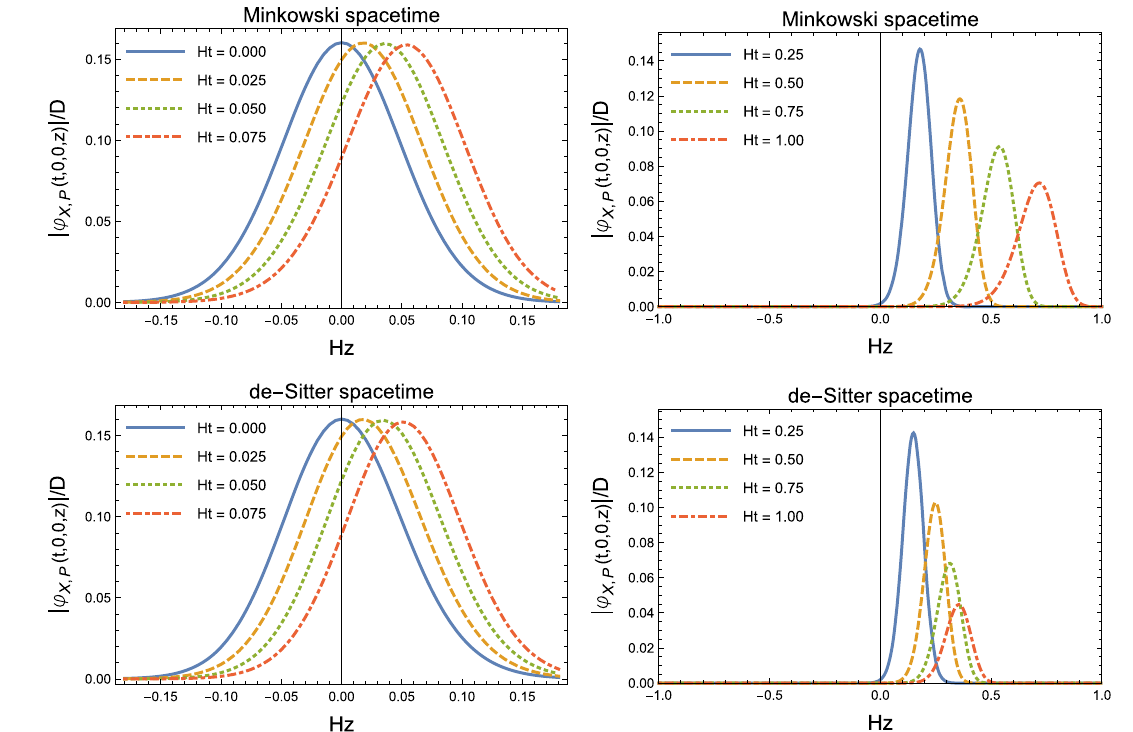
Fig. 5 The absolute value of the wave packet ϕ X , P ( x ) as a function while, in de-Sitter spacetime, H is equal to its Hubble constant. In de- Sitter spacetime, the wave packet (50) evolves as (22) in flat spacetime of time in Minkowski spacetime (top panel) and in de-Sitter spacetime for small values of Ht , in accordance with the equivalence principle. (bottom panel), assuming that M / D = 10, M / H = 100 (cid:12) 1 and √ At later times, Ht (cid:5) 0 . 1, the Minkowski and de-Sitter wave packets the initial conditions X = 0 with P = ( 2 M , 0 , 0 , M ) . Note, we behave differently. One can also easily see that the probability to find a make use of dimensionless time and space coordinates, i.e. Ht and Hz , scalar-field particle on the classical geodesic is maximal in both where, inMinkowski spacetime, H ismerelya dimensionful parameter,